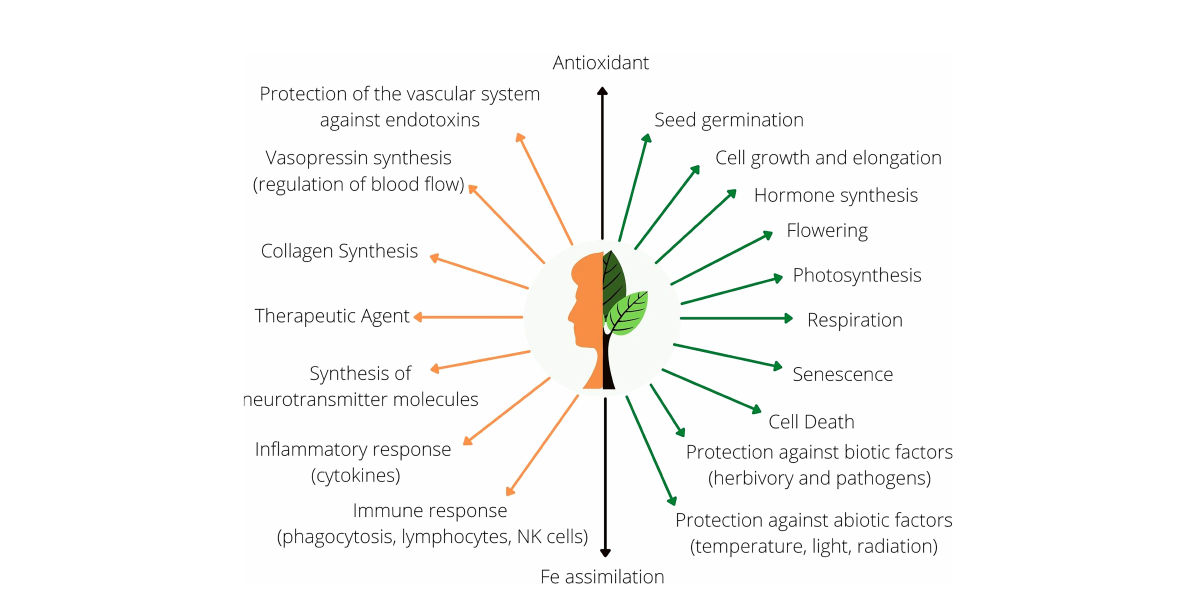
FIGURE 1 General overview of the functions of AsA in animal (orange) and plant (green) metabolism. Black arrows represent common molecular functions in both human and plant